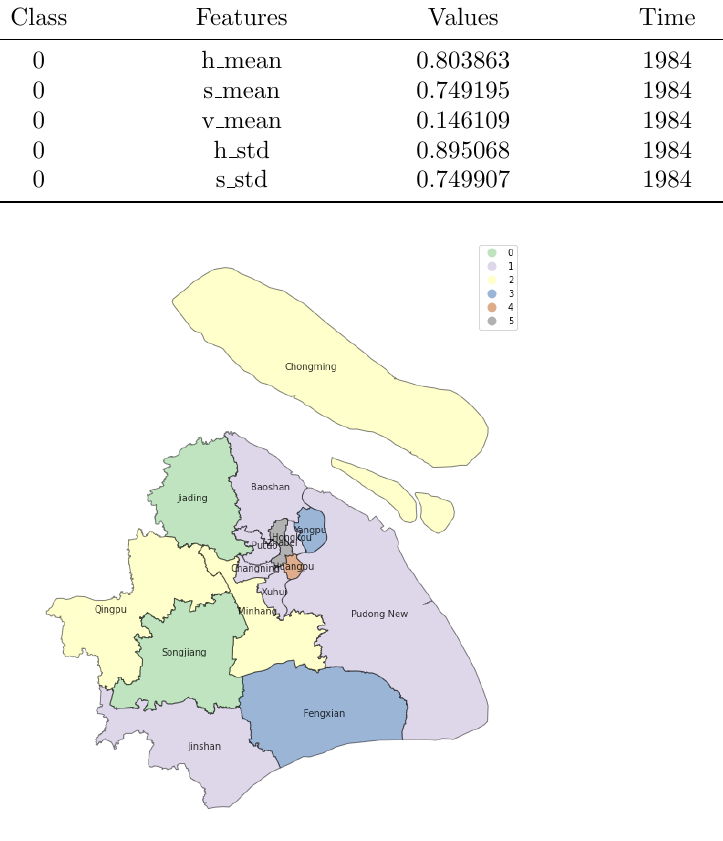
Table 16: Tidy table represents mean values of features for each cluster at different years Class Features